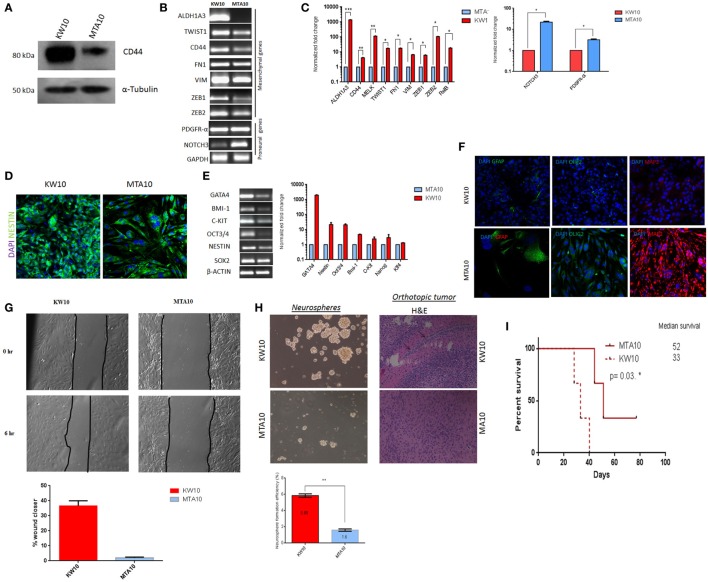
KW10 and MTA10 cell cultures represent mesenchymal and proneural glioblastoma subtypes. (A) Western blotting of the mesenchymal-specific marker CD44. (B) Semiquantitative RT-PCR for mesenchymal and proneural genes; GAPDH served as internal loading control. (C) qRT-PCR for known mesenchymal and proneural specific transcripts. Values represent normalized fold changes ± SEM of MTA10 and KW10 cell cultures, *p < 0.01. (D) Immunofluorescence detection of nestin expression. (E) RT-PCR analysis of stemness markers and quantification of stemness gene expression. Normalized fold change is represented as compared to MTA10 cells (mean ± SEM), n = 3. β-Actin served as internal control. PCR was performed in 7500 Fast real-time PCR system (Applied Biosystems) using SYBR Green Master Mix (Applied Biosystems). Data were normalized using the ΔCt method, and fold change was calculated using the 2−ΔΔCt method. (F) Immunofluorescence staining of neural differentiation markers. (G) Scratch assay and quantification. (H) Neurosphere formation assay and its quantification. Data are represented as mean ± SEM, **p < 0.001, n = 3. Representative H&E staining of orthotopically implanted KW10 and MTA10 cells in mouse brain tumor tissue regions. Arrows show infiltrating cells within the tumor xenograft. (I) Survival analysis of KW10 and MTA10-injected SCID mice; data indicate that mice injected with KW10 cells show reduced survival (33 days) as compared to mice injected with MTA10 cells (52 days) (n = 3; *p = 0.03).